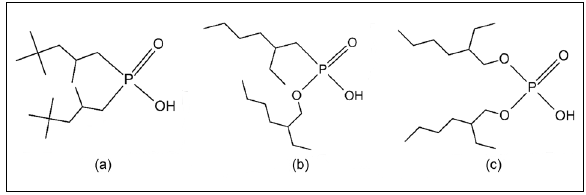
Figure 2: Simplified chemical structure of (a) Cyanex 272, (b) PC-88A, and (c) D2EHPA.